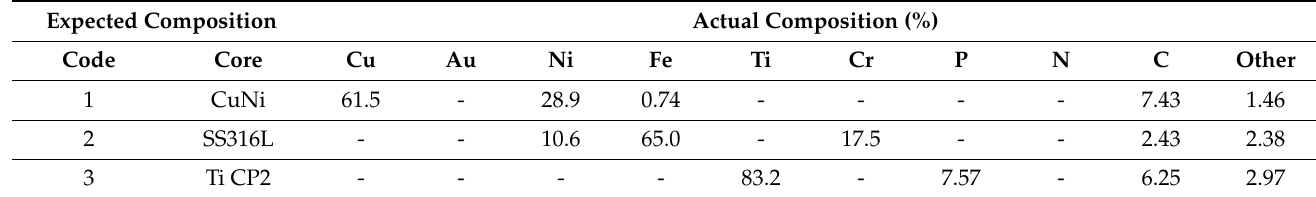
Table 5. External surface EDX results of contaminants.